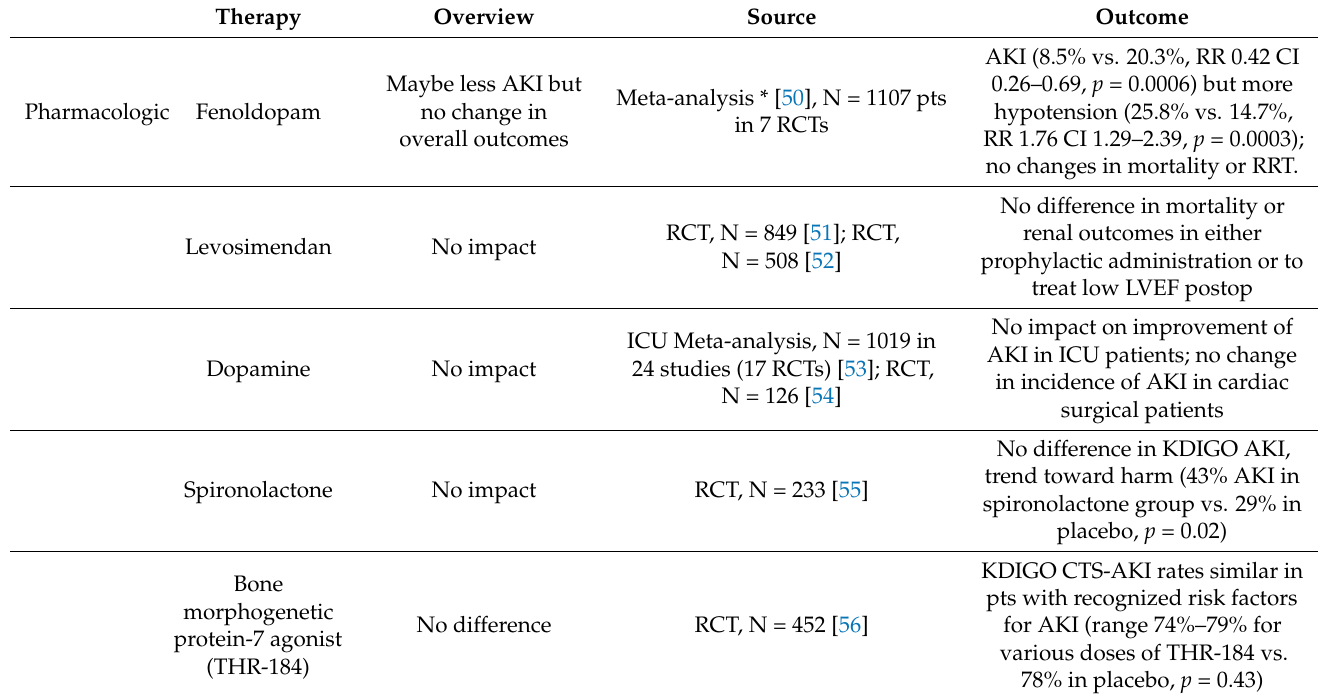
Table 4. Single-agent therapies for treatment of